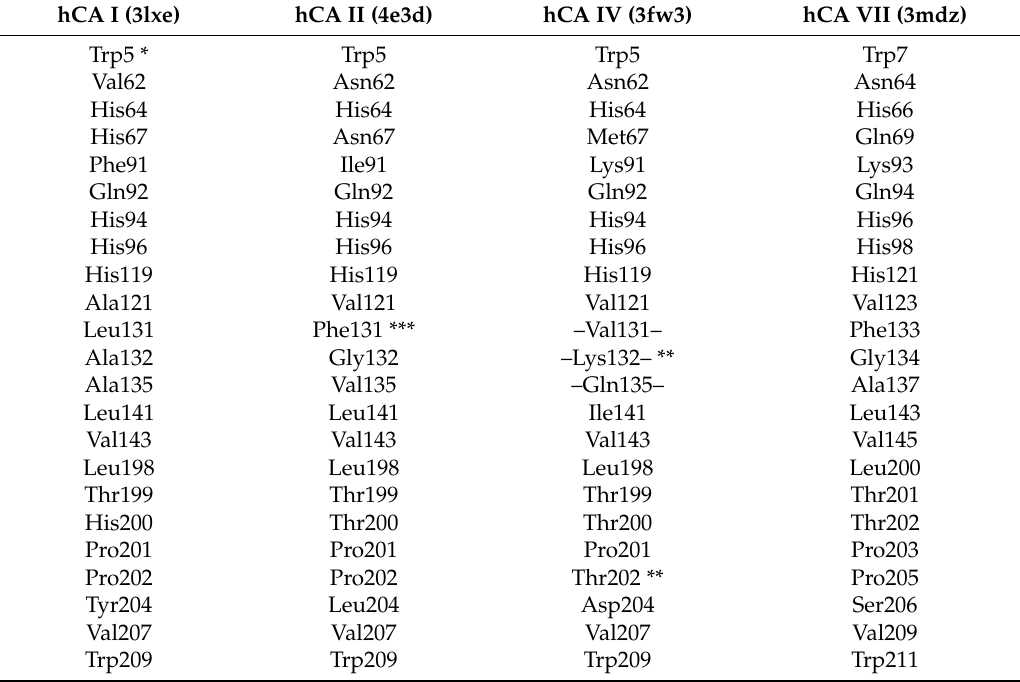
Table 2. Comparison of the active sites among the four selected hCA